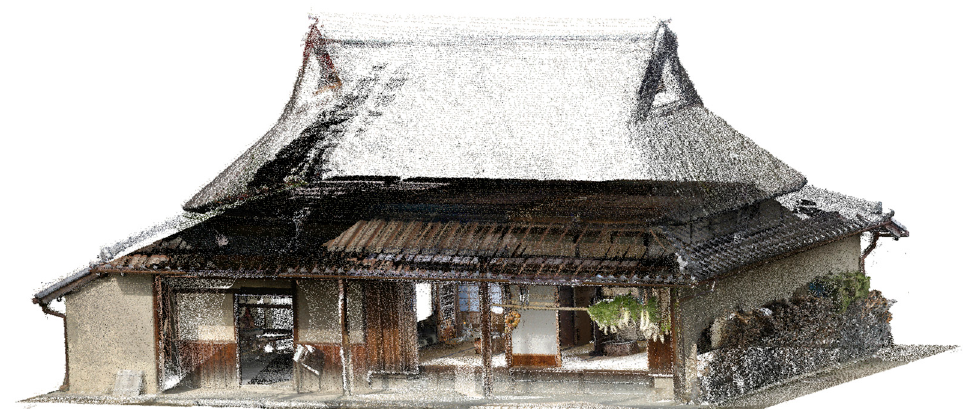
Figure 4. The 3D laser-scanned data of the former Nakajima Residence, which is a traditional Southeast Asian folk house (24,074,424 points).